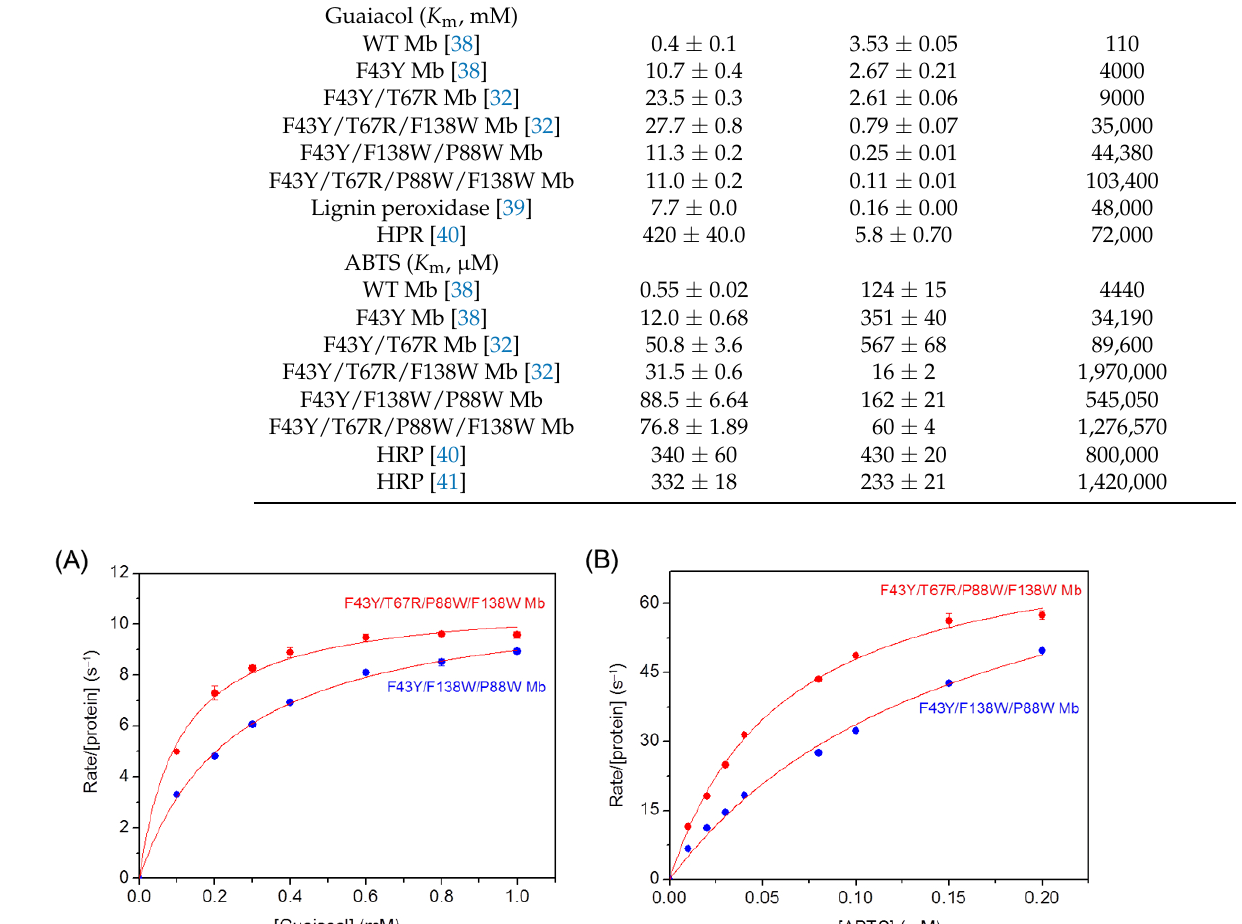
Table 1. Kinetic parameters for H 2 O 2 -dependent oxidation of guaiacol and ABTS catalyzed by Mb and its mutants. Measurements were performed in 50 mM potassium phosphate buffer at pH 7.0, 25 ◦ C. The parameters of natural lignin peroxidase and HRP are shown for comparison. Enzyme